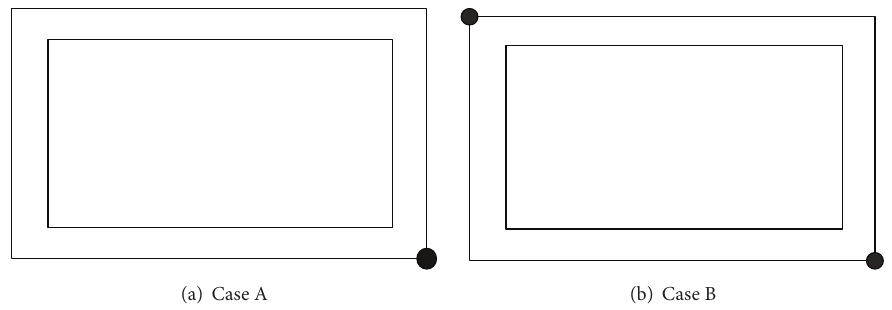
Figure 20: Position of the non-structural mass at the tip cross-section of the hollow-rectangular box beam.